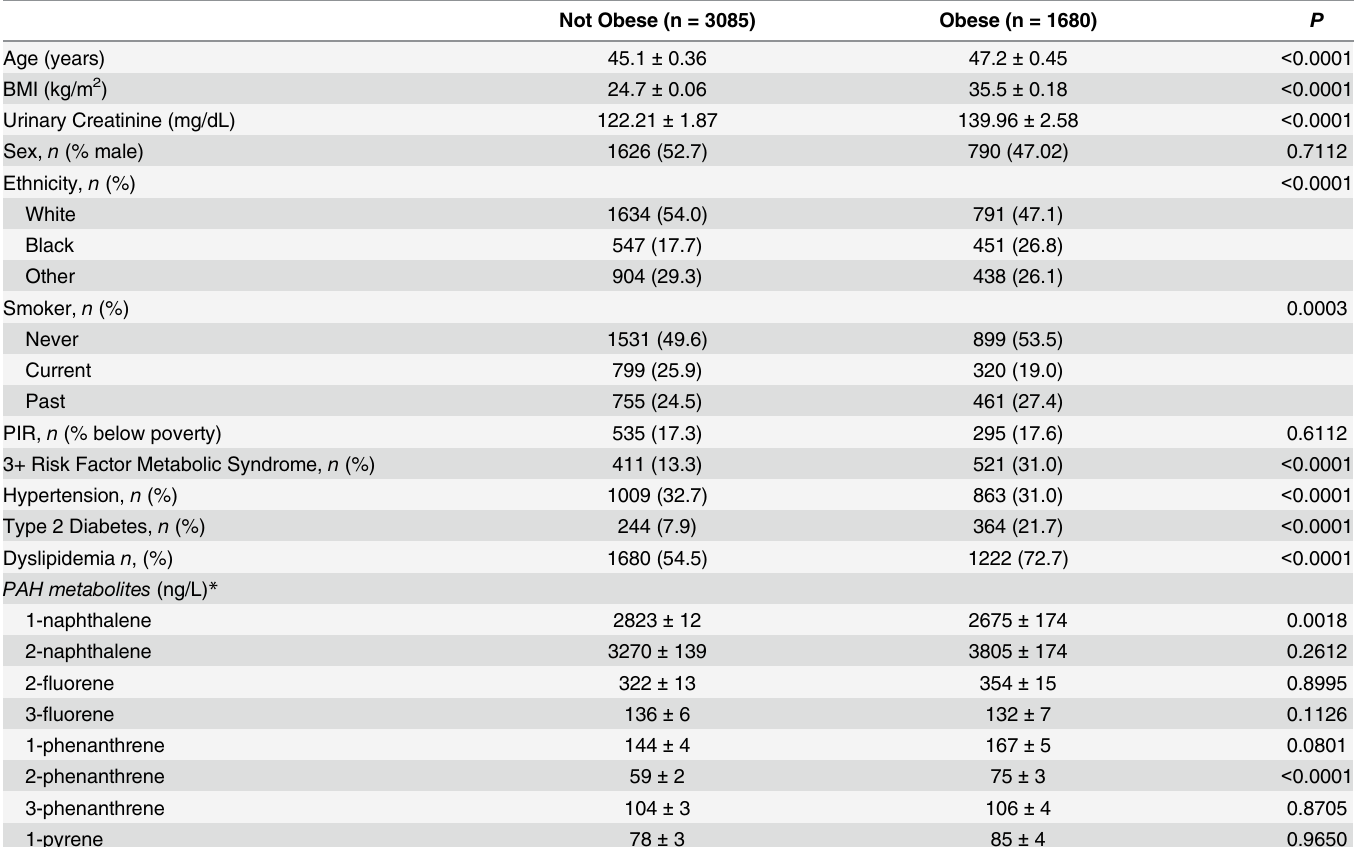
Table 1. Participant characteristic and obesity